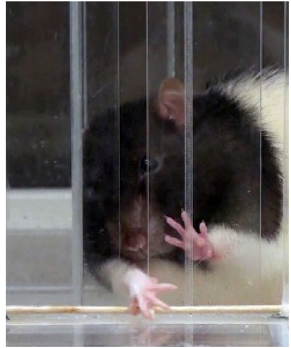
Figure 2. Rats were trained to reach through an opening in a Plexiglas chamber to retrieve small food-pellets located on a shelf placed 3 cm above the floor outside the chamber. A movable wall inside the chamber allowed the rat to use only his preferred forelimb (for TBI groups this was the forelimb contralateral to the TBI). Performance was assessed once per week during two weeks of baseline training, once per week for first 4 weeks after TBI and then once every four weeks up to 16 weeks after